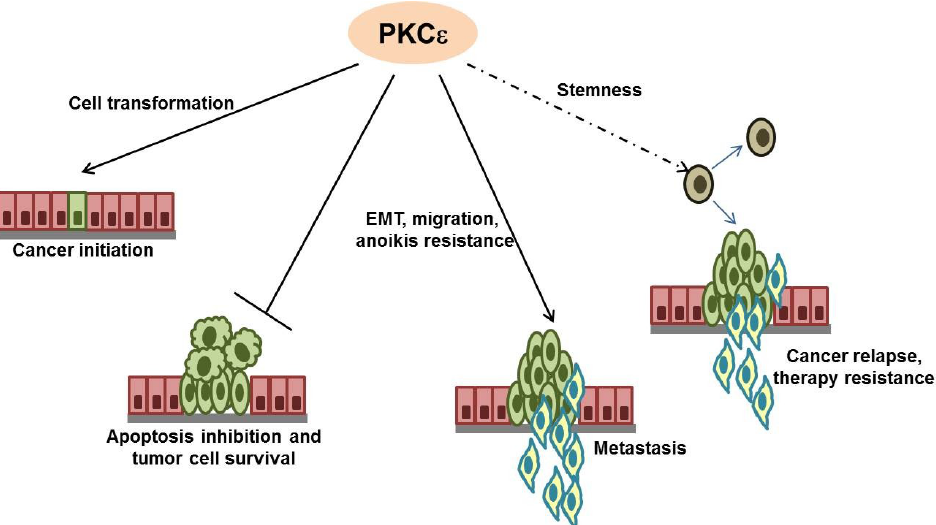
Figure 1. The involvement of PKCɛ in various steps of cancer development and